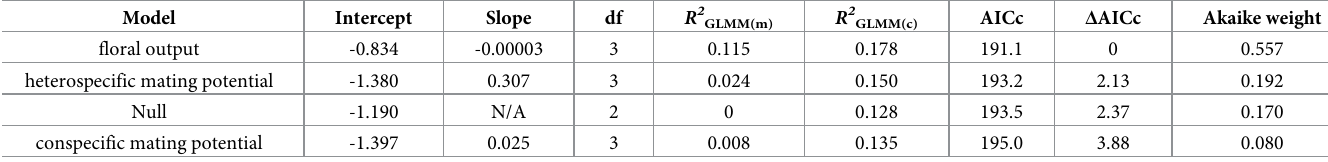
Table 6. Summary of model selection results for fruit set in C . orbiculatus .